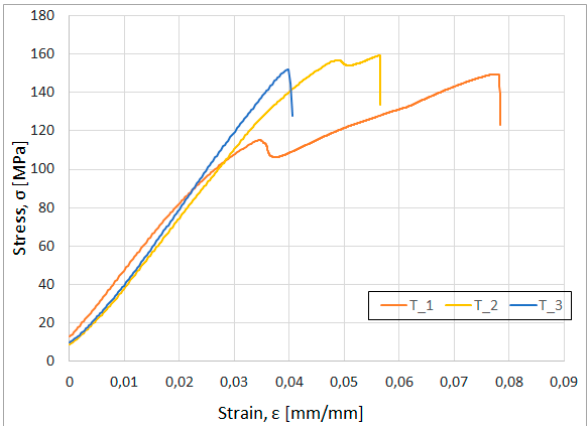
Figure 10. Results of uniaxial tensile test for the 3K yarn with four layers (c) the authors, CC BY-NC-ND 4.0 [17].